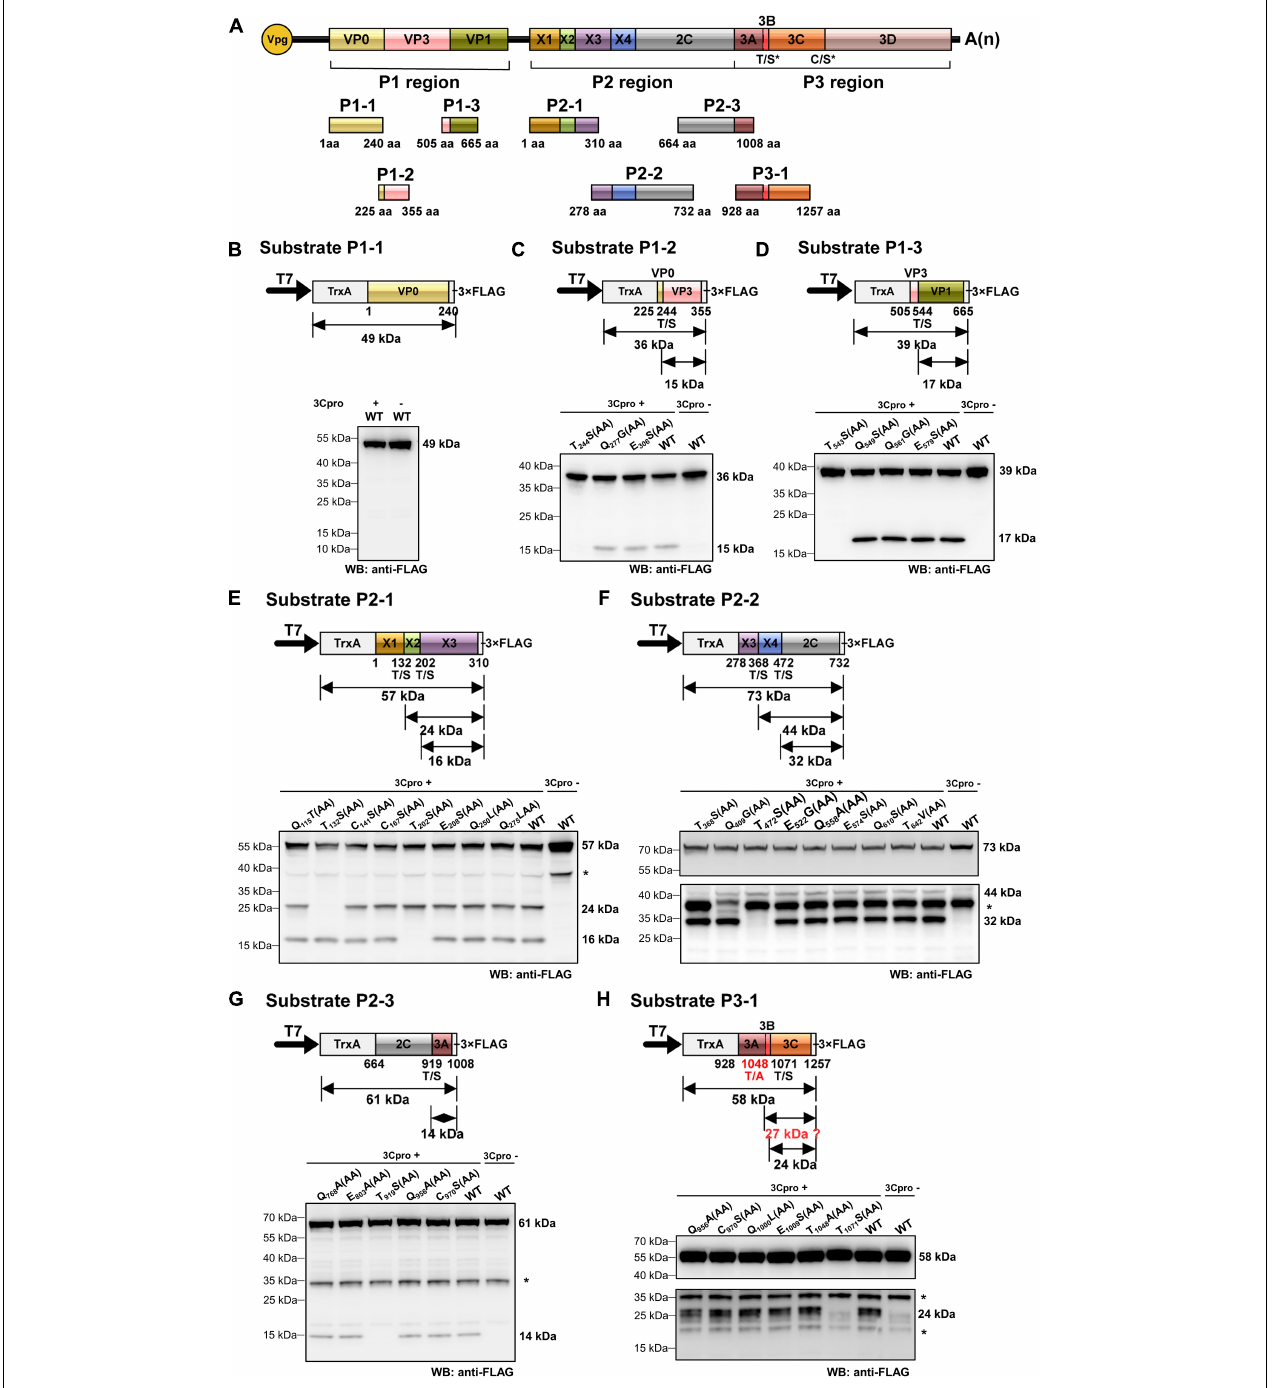
FIGURE 4 | Identification of cleavage sites in rice curl dwarf-associated picornavirus (RCDaV) polyproteins using in vitro trans -cleavage assay. (A) Schematic representation of protein segments from the three regions of RCDaV. (B–D) In vitro trans -cleavage analyses using the P1-1, P1-2, and P1-3 protein segments from P1 region as the substrates. (E–G) In vitro trans -cleavage analyses using the P2-1, P2-2, and P2-3 protein segments from P2 region as the substrates. (H) In vitro trans -cleavage analysis using the P3-1 protein segment from P3 region as the substrate. Site-directed mutants of the predicted cleavage sites were also used in individual assays. The calculated molecular mass of each protein segment is shown on the right side of the figure. The asterisks in (E–H) indicate non-specific protein bands. The lower panel blots in (F,H) were exposed for longer time to show the bands. Predicted T/A cleavage site is shown with a dashed line in (H) , since processing was not detected at this site in the in vitro assays. Numbers below the boxes indicate amino acids positions.